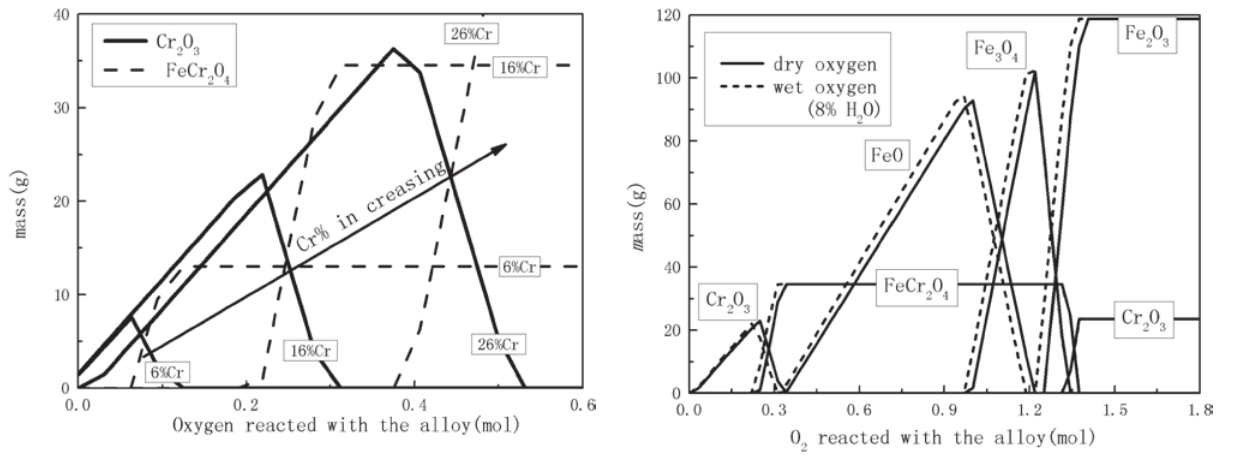
Fig. 5: Equilibrium of dry and wet oxygen to 100 g Fe-16Cr alloy at 800